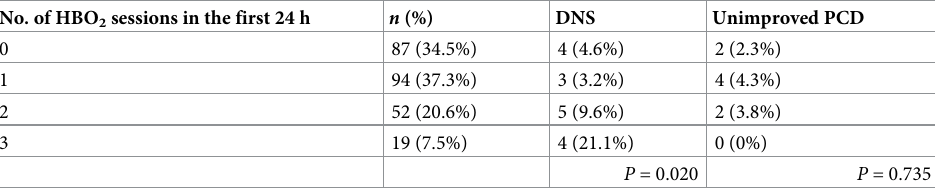
Table 4. Number of HBO 2 therapy sessions in the first 24 h and incidence of neurological sequelae. No. of HBO 2 sessions in the first 24 h